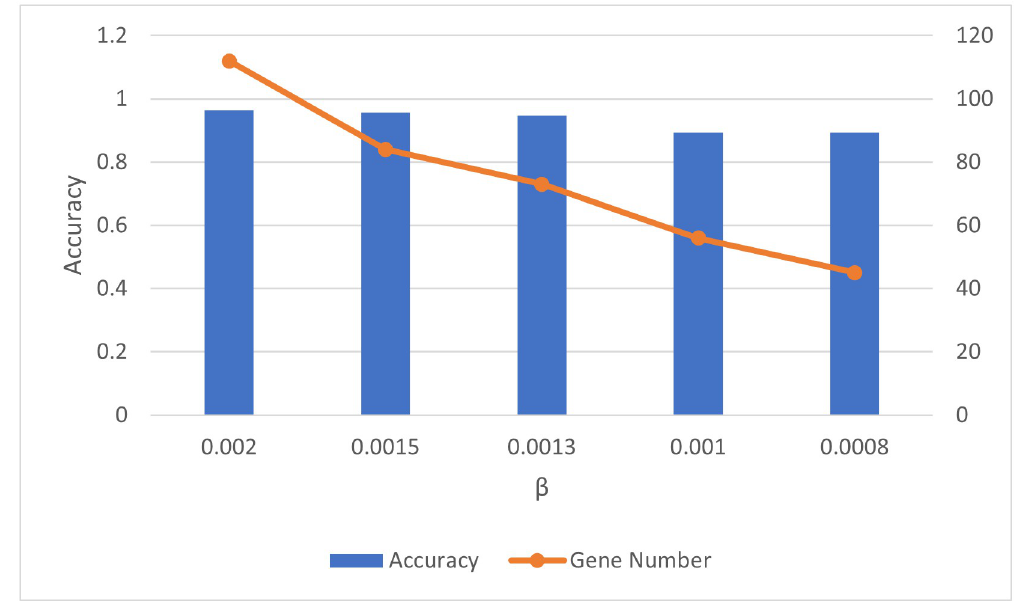
Fig 4. Accuracy vs different β values of first phase PCA on THCA